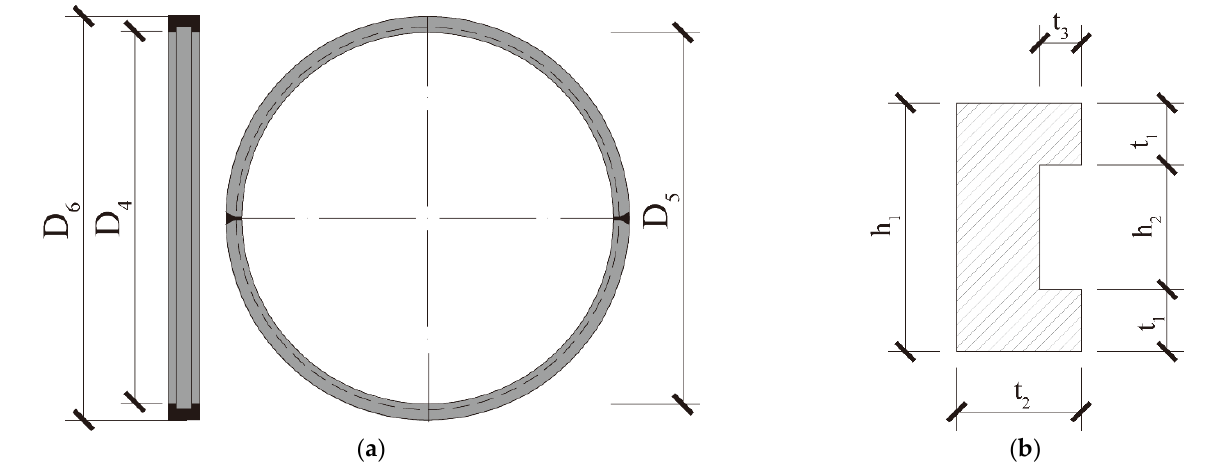
Figure 4. Parameters of various parts of the clamp ring: ( a ) side and front view, ( b ) sectional drawing.